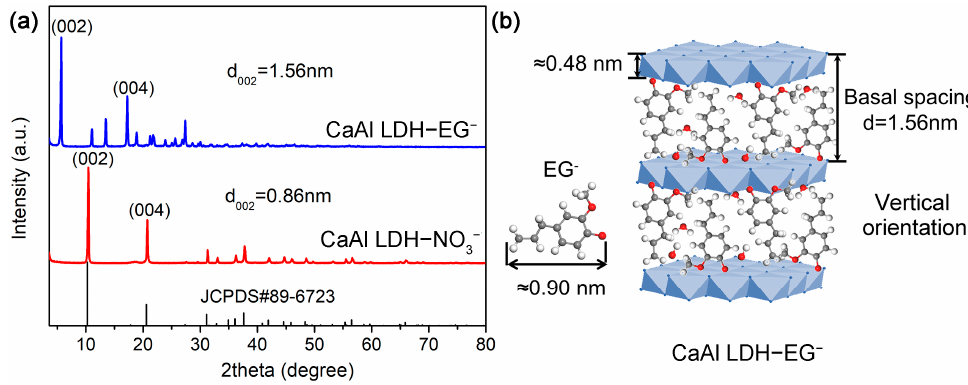
Figure 2. SEM images of: ( a ) the synthesized CaAl LDH − NO 3 − ; ( b ) the enlarged SEM images of ( a ).